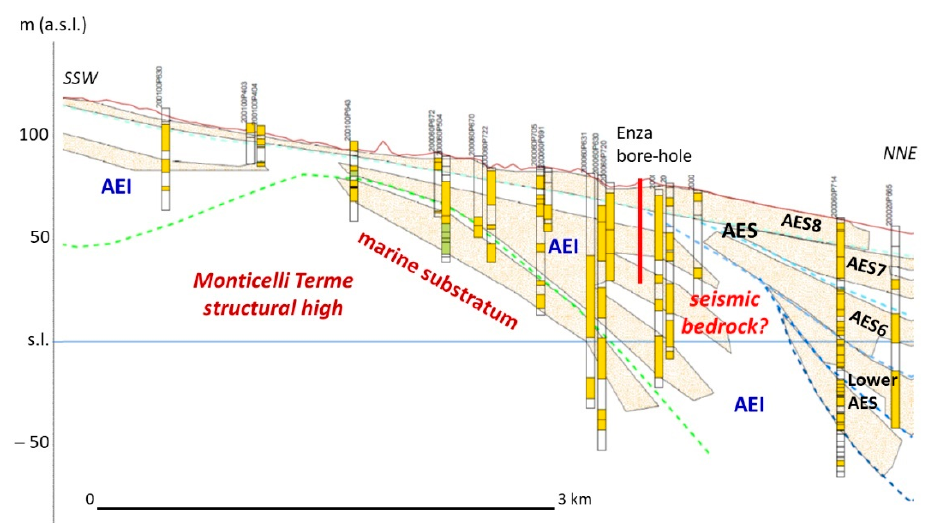
Figure 12. Geological cross-section across the Enza River alluvial fan (from https://geo.regione.emilia-romagna.it/cartografia_sgss/user/viewer.jsp?service=sezioni_geo, accessed on 1 July 2021, with modifications).